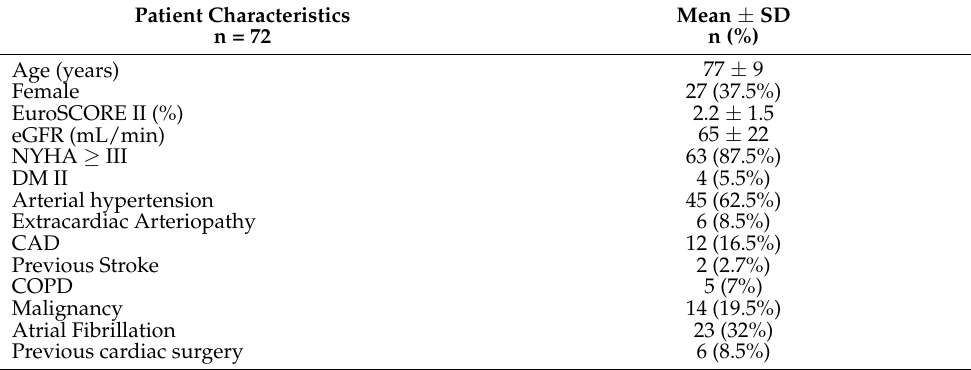
Table 1. Baseline demographic and clinical characteristics.